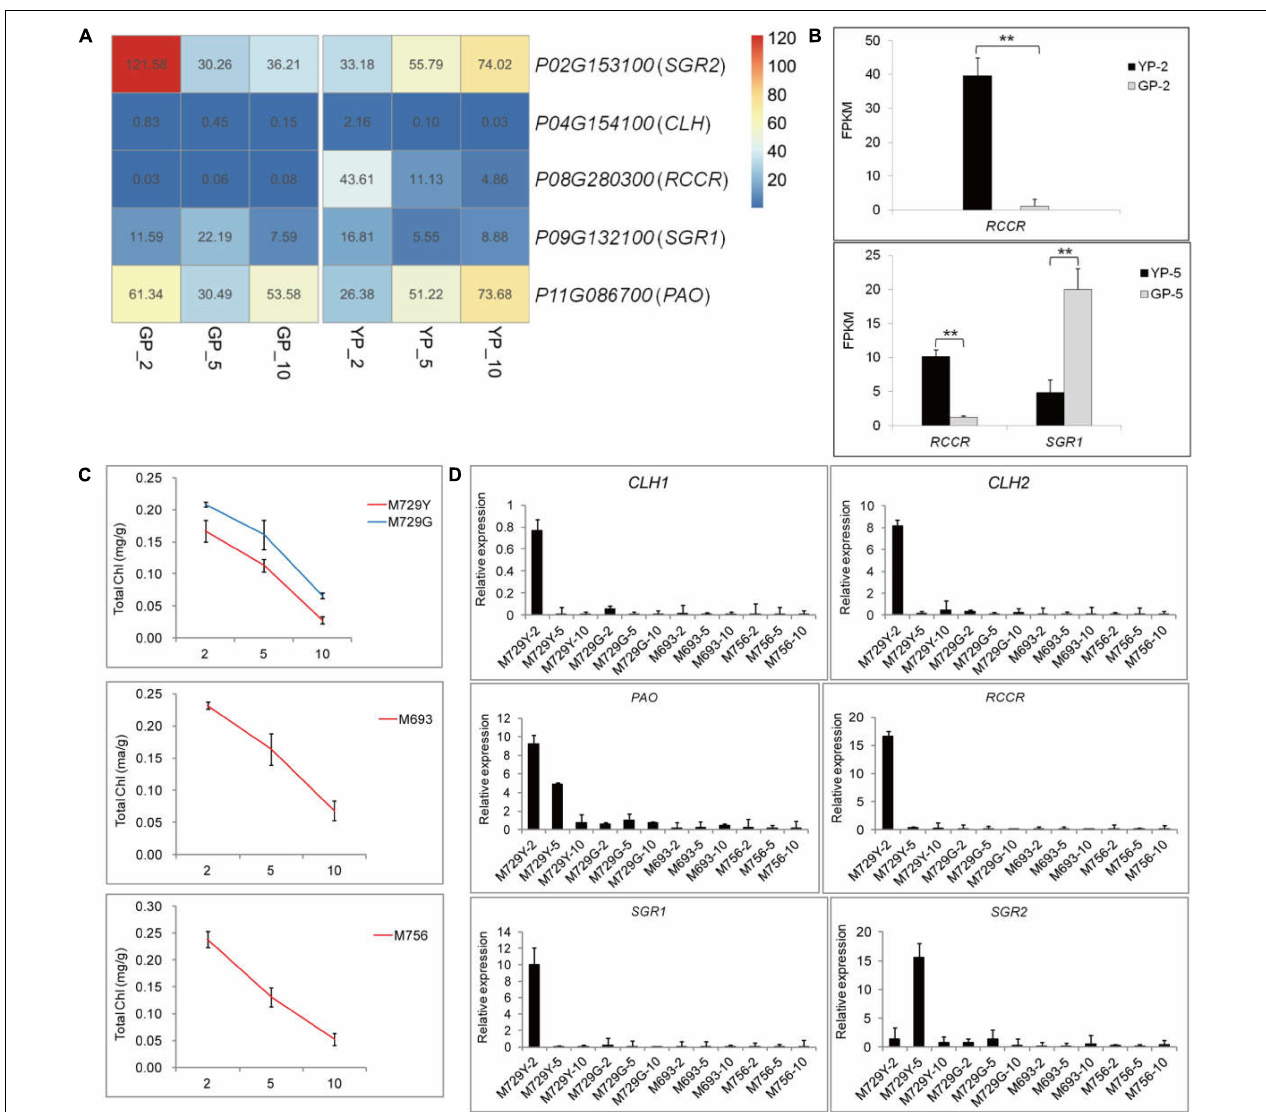
FIGURE 3 | The differential expression genes analysis in porphyrin and chlorophyll metabolism pathway of YP, GP, and the other green pod mutant lines. (A) The changes in gene expression level of degradation in YP and GP, respectively. (B) Expression levels of DEGs for chlorophyll degradation between YP-2 and GP-2 and YP-5 and GP-5, respectively. (C) The chlorophyll content in yellow pods (M729Y) and three green pod mutants (M729G, M693, and M756), respectively. (D) Expression levels of DEGs for chlorophyll degradation successively in the M729Y, M729G, M693, and M756 mutant lines. Error bars represent the standard deviation of three replicates. Data were analyzed using the t -test. * p < 0.05, ** p <